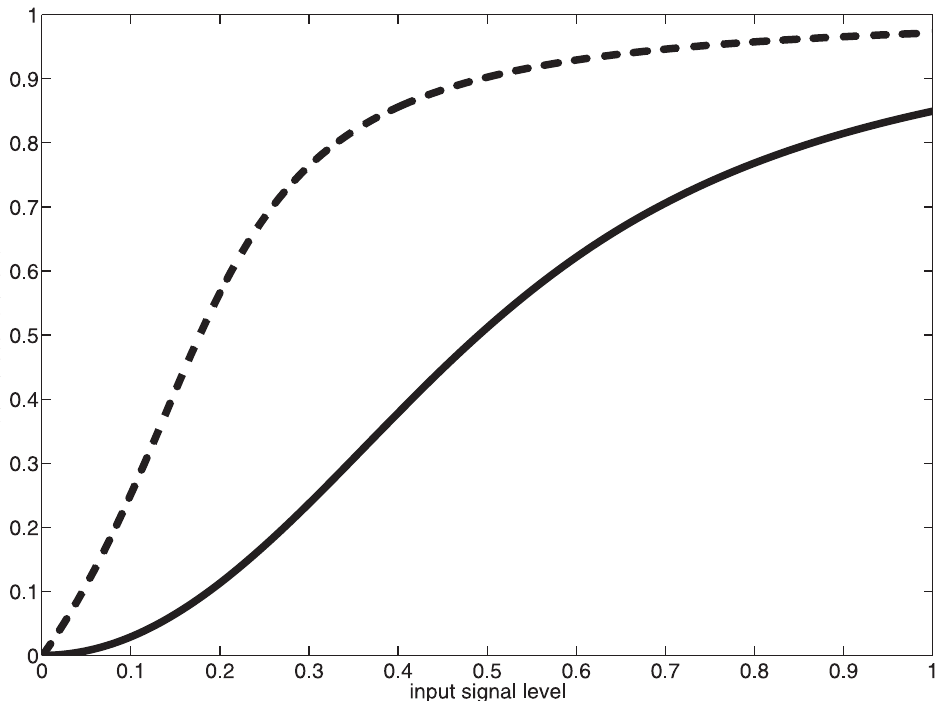
Figure 11. Abrogation of Fus3-scaffold interaction can lead to loss of ultrasensitive Fus3 response. Wild-type (solid, k on ~ 0 : 1 , total activated scaffold) and Fus3-less (dashed, k on ~ 10 , free active Fus3) scaffold system responses are plotted for k off ~ 0 : 1 .